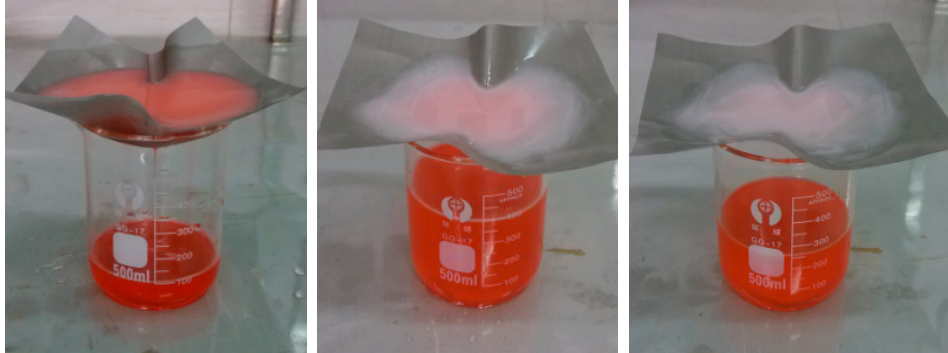
Figure 10. Renderings of membrane separation of oil and water emulsion.